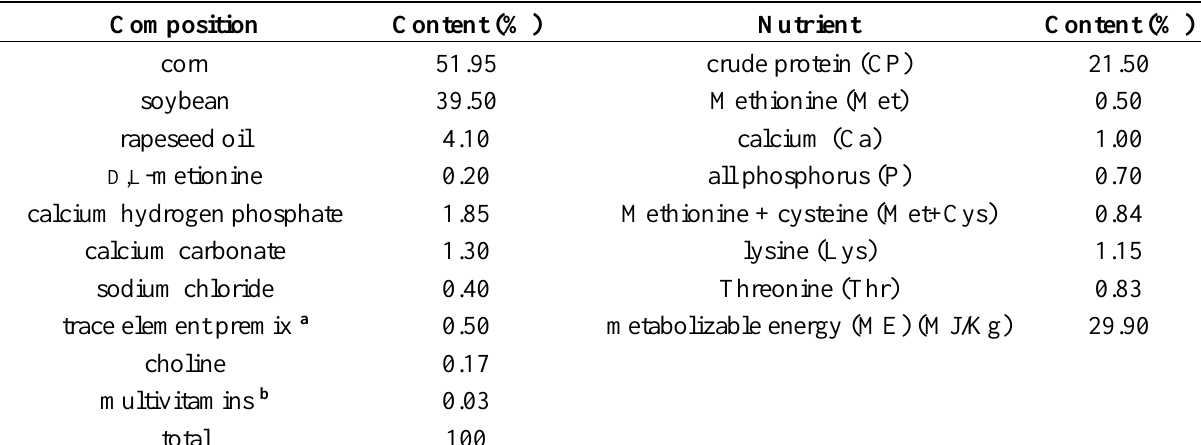
Table 1. Composition of the Basal